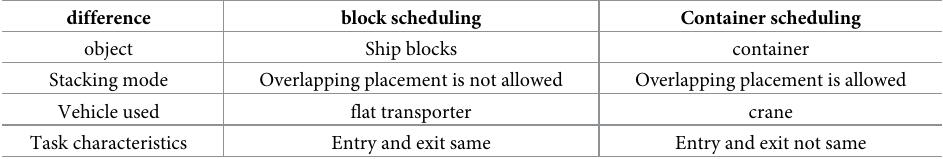
Table 2. Difference between block scheduling and container